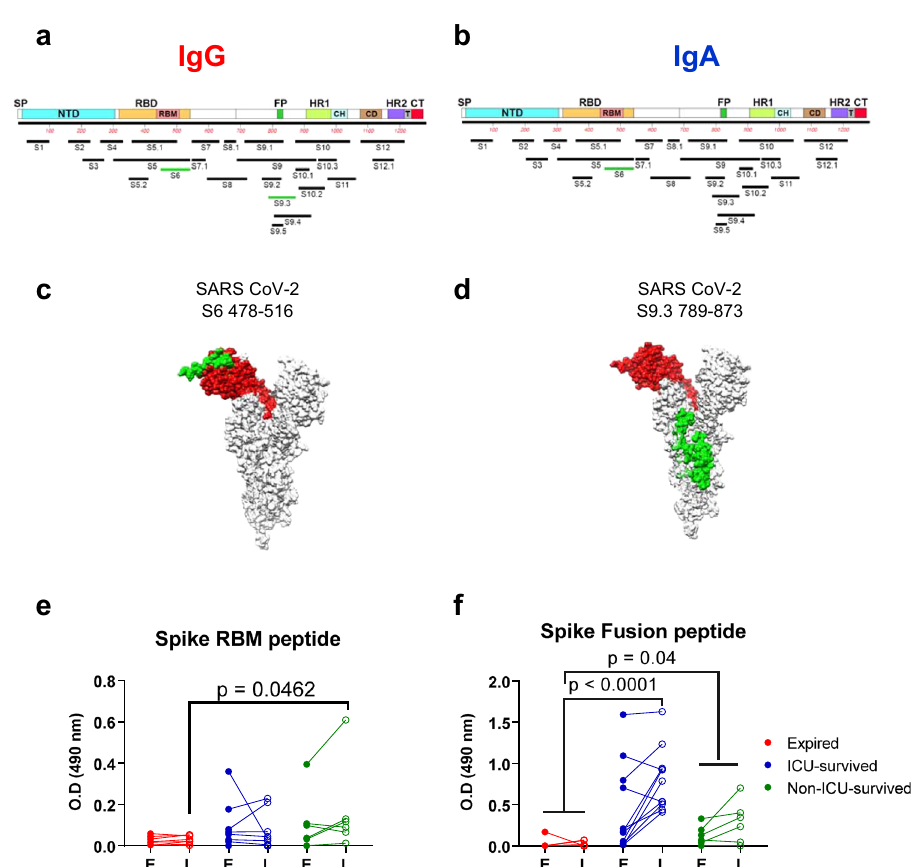
Fig. 4 Antibody epitope pro fi le against the Spike protein following SARS-CoV-2 infection. Antigenic regions/sites within the spike protein recognized by plasma antibodies following SARS-CoV-2 infection (based on data presented in Fig. 3). The amino acid designation is based on the spike protein sequence encoded by the SARS-CoV-2 Wuhan-Hu-1 strain (GenBank: MN908947.3) spike. The antigenic regions/sites discovered using the post-infection antibodies are depicted below the SARS-CoV-2 spike schematic. The epitopes of each protein are numbered in a sequential fashion indicated in black. Antigenic sites shown in green letters (SARS CoV-2 S6 and S9.3) were uniquely recognized by post-SARS-CoV-2 infection IgG ( a ) or IgA ( b ) antibodies only in the “ survived ” but not from expired COVID-19 patients (as shown in Fig. 3). c , d Structural representation of S6 ( c ) and S9.3 ( d ) antigenic sites depicted in green on the surface of a monomer in a trimeric spike (PDB#6VSB) with a single receptor-binding domain (RBD) in the up conformation, wherever available using UCSF Chimera software version 1.11.2. The RBD region is shaded in red (residues 319 – 541) on both structures. e , f Seroreactivity of COVID-19 plasma samples with the selected synthetic peptides covering epitope S6 (receptor-binding motif; RBM) and peptide S9.3 (fusion peptide; FP). Absorbance at 100-fold dilution of early fi rst sample (E) or last (L) sample from SARS-CoV-2 infected individuals were tested for binding to RBM (panel e ) and FP (panel f ) in IgG ELISA. The statistical signi fi cances between “ expired ” patients (red; n = 8 biologically independent individuals), “ ICU- survived ” patients (blue; n = 11 biologically independent individuals), and “ non-ICU survived ” patient (green; n = 6 biologically independent individuals) groups were determined by non-parametric (Kruskal – Wallis) statistical test using Dunn ’ s multiple comparisons analysis in GraphPad prism. p -values <0.05 were considered signi fi cant with a 95% con fi dence